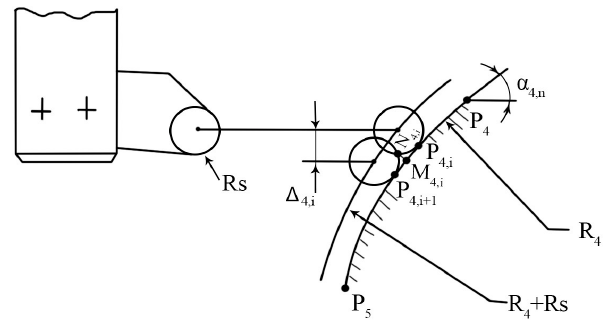
Figure 6. The occurrence of the deviation of the geometric shape-convex generator curve.